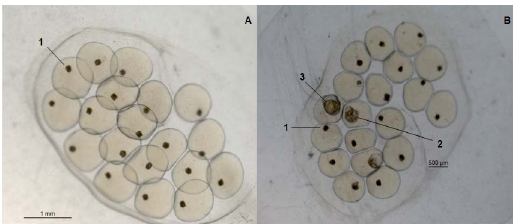
Figure 3. B. glabrata embryos exposed to piplartine at the blastula stage. A ) Immediately following exposure to 1.2 m g/ml piplartine, B ) during the 7 day observation period after exposure to 1.0 m g/ml piplartine (1- dead, 2 - normal, 3 – malformed).